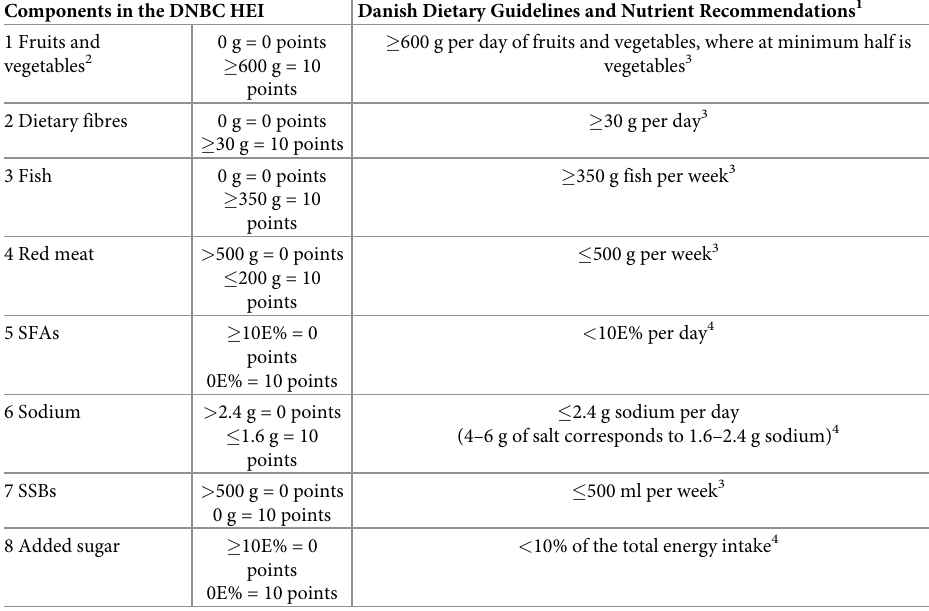
Table 1. The HEI developed within the DNBC. Components in the DNBC HEI Danish Dietary Guidelines and Nutrient Recommendations